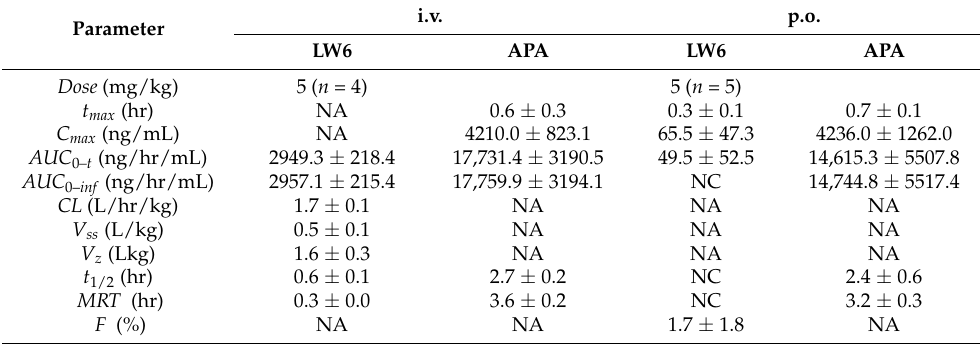
Table 1. Pharmacokinetic parameters were obtained following a single dose of LW6 in mice.